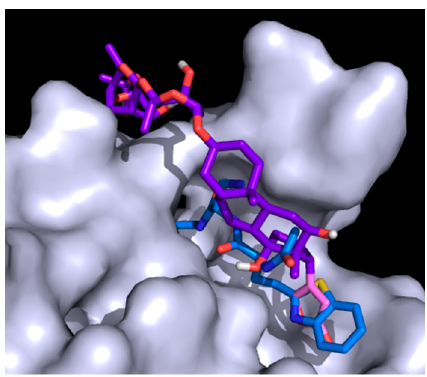
Figure 7. Digoxin (purple) and VIR250 (blue) interaction with PLpro (grey) active site.